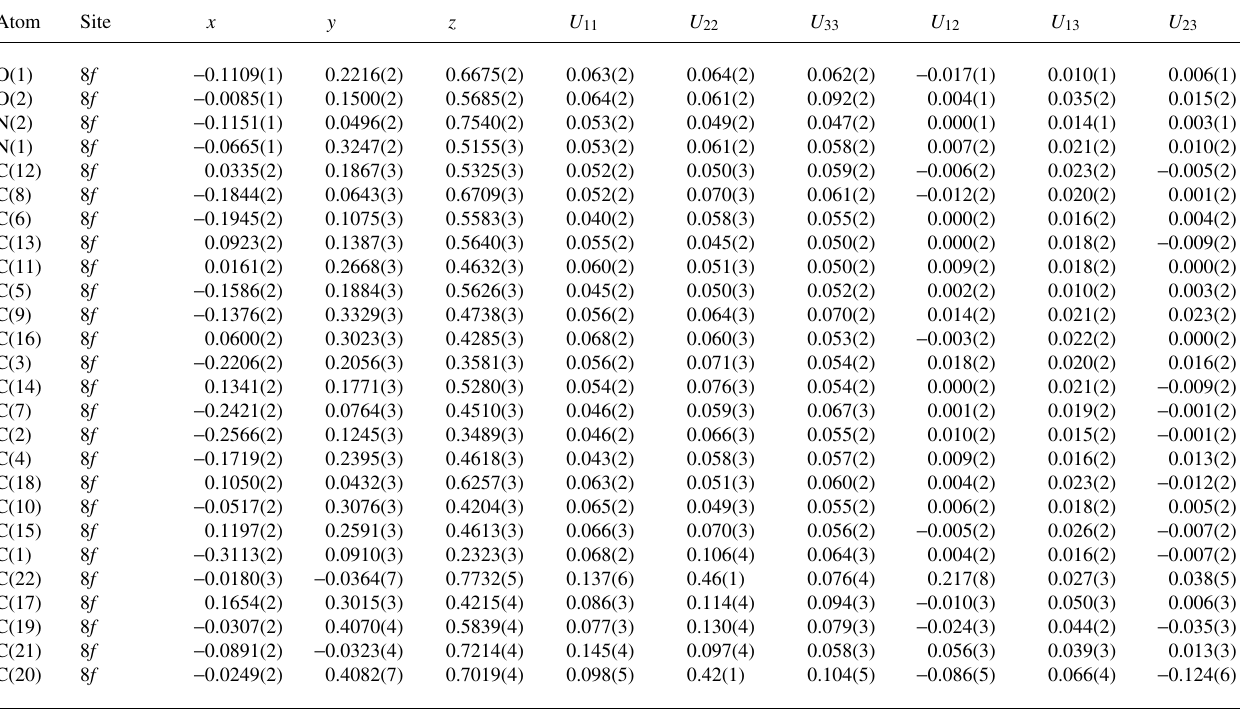
Table 3. Atomic coordinates and displacement parameters (in Å 2 ) .